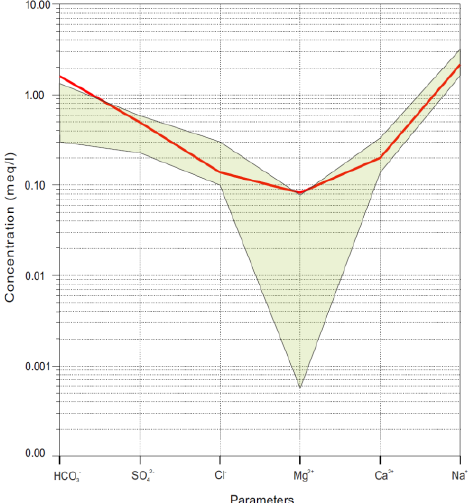
Figure 4. The proportion of major ions in the chemical composition of waters from the LZT-1 borehole as compared to the composition of waters from spa intakes plotted on the Schoeller diagram (based on [79] updated).